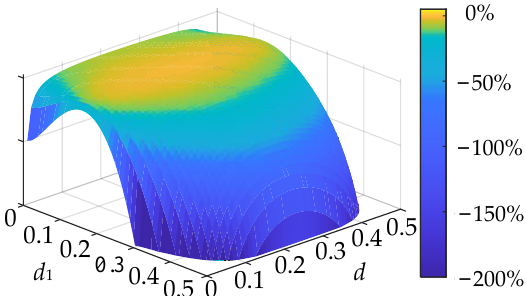
Figure 6. Showing 3D plots of Y Q varying with d 1 and d .